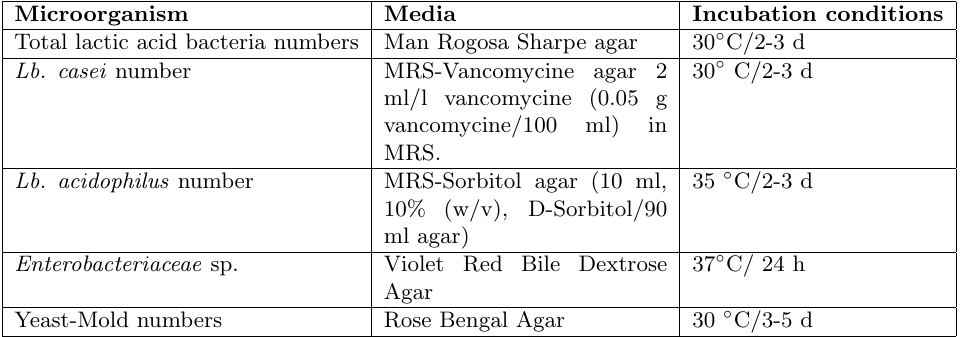
Table 1. Media and incubation conditions used for determining microorganism